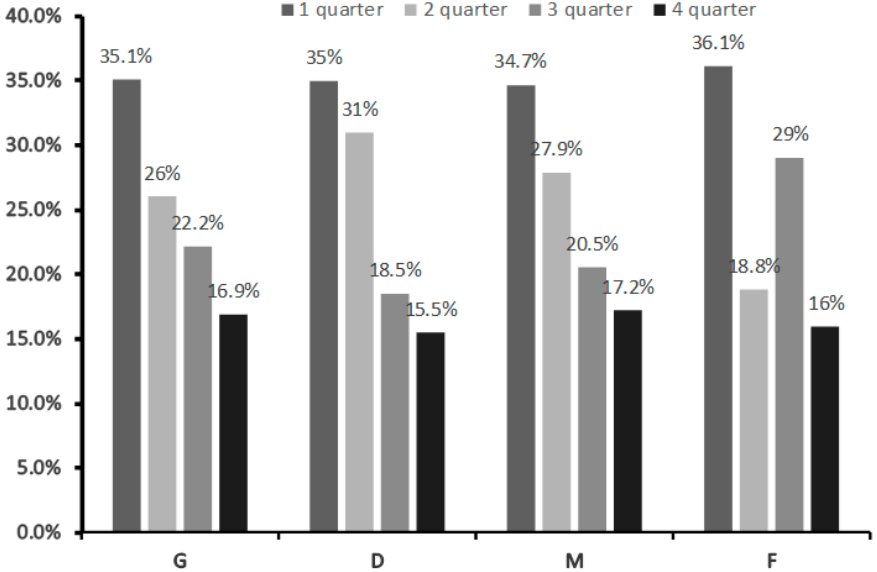
Figure 6. Relative age effect (RAE) by playing position among adult Russian football players who played in all RPL teams from 2001 to 2017 (total n = 7263). G = goalkeeper, D = defender, M = midfielder, F = forward.